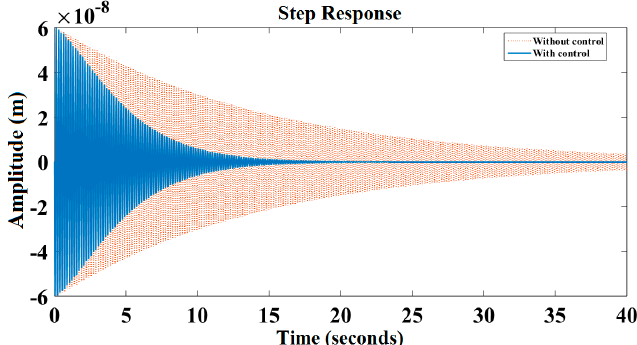
Figure 5. Step response of the beam (Sensors in FE1, Q = 10 11 , R = 1, Gc = 100).